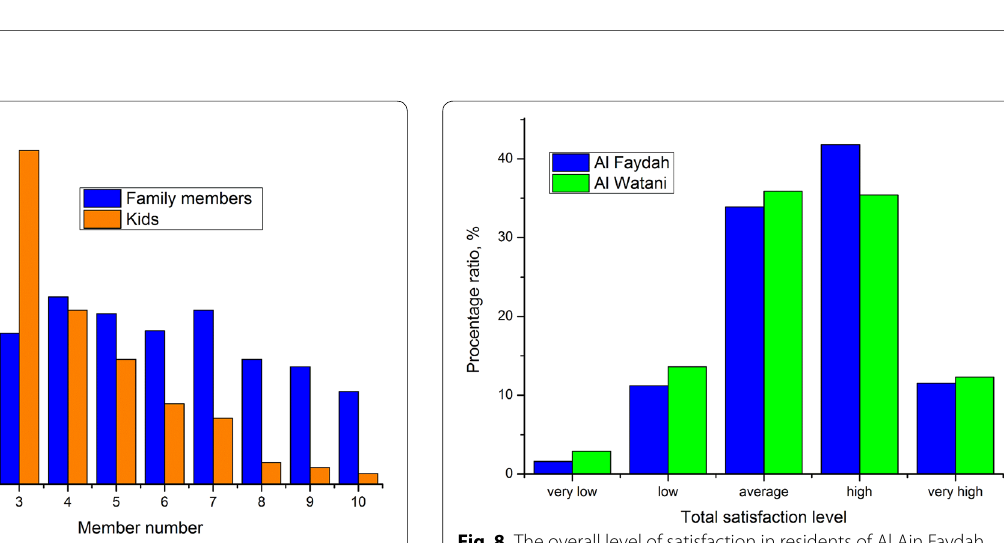
Fig. 7 Results of a demographic study of the Al-Ain Faydah residential area